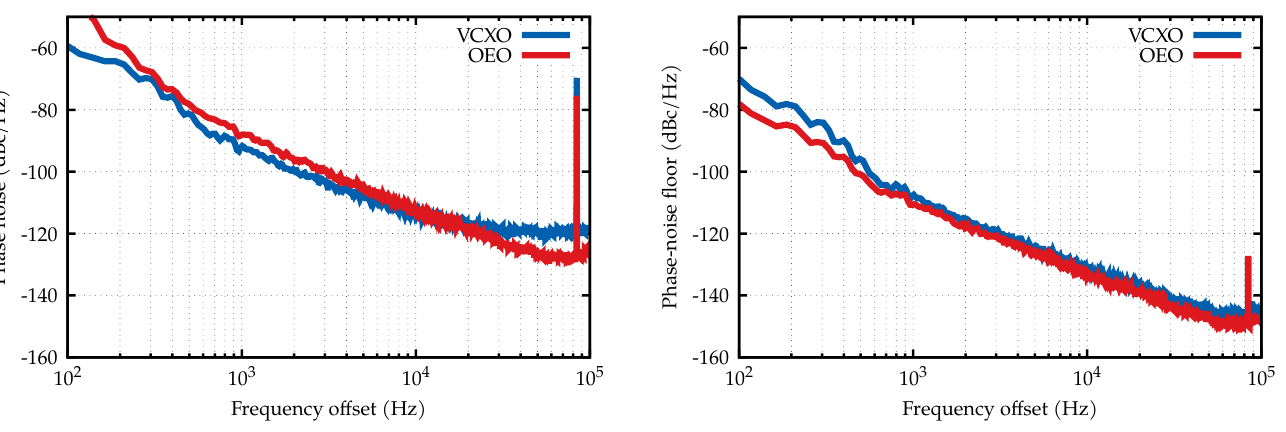
Figure 8. Measurement of phase noise and system noise floor